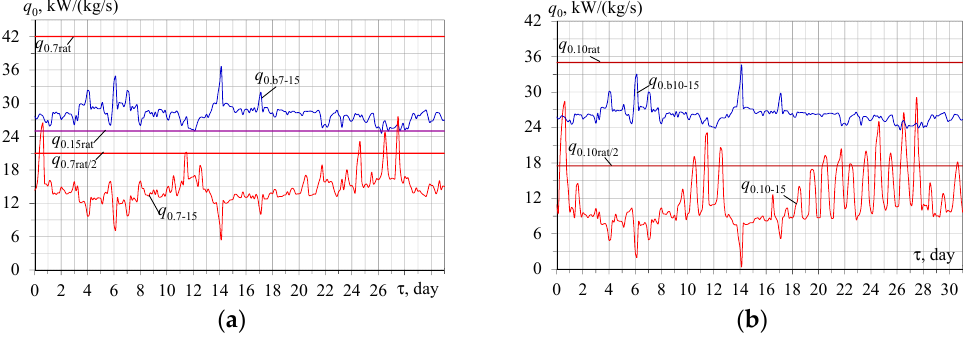
Figure 11. Actual values of refrigeration capacities q 0.7–15 for air conditioning from 15 to 7 ° С and residual booster values q 0.b7–15 ; relative booster refrigeration capacities values q 0.b7–15 / q 0.7rat ( a ); corresponding refrigeration capacities q 0.10–15 and q 0.b10–15 and relative booster refrigeration capacities values q 0.b10–15 / q 0.10rat ( b ) for air conditioning to the set temperatures of 7 and 10 ° С , accordingly: q 0.b7,10–15 = q 0.7,10rat − q 0.15 ; q 0.7,10–15 = q 0.7,10 − q 0.15 for air conditioning to 7 and 10 ° С .